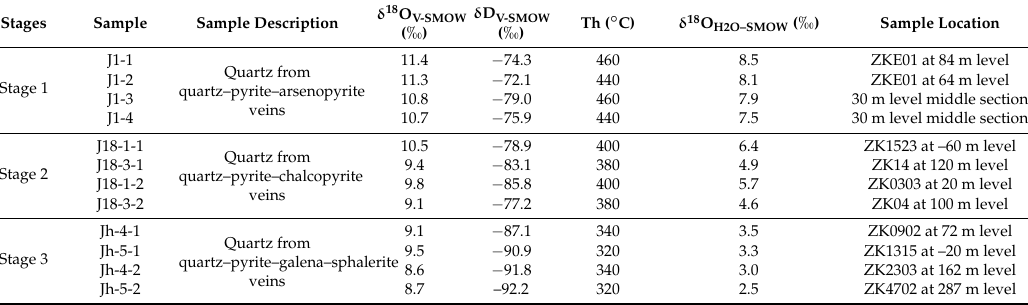
Oxygen and hydrogen isotopic data for Stage 1–3 hydrothermal quartz from the Jinchang